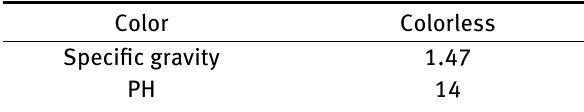
Table 6: Physical properties of sodium hydroxide